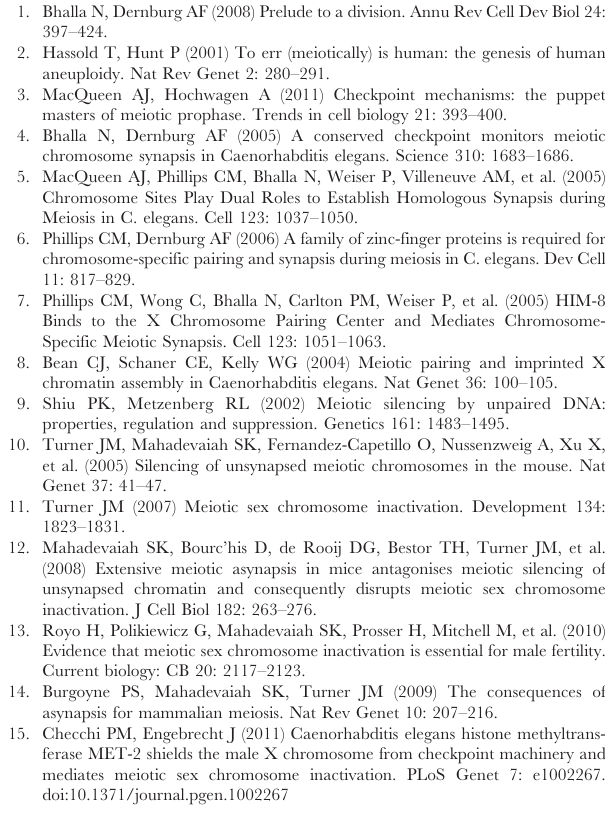
Figure S3 The delay in meiotic progression observed in meDf2 heterozygotes is not affected by mutation of mes-4 . Indirect immunofluorescence was performed against SUN-1 phosphory- lated on serine 8 in germlines from wildtype hermaphrodites, meDf2/ + mutant hermaphrodites and meDf2/ + ; mes-4 double mutants. (PDF) Figure S4 The delay in meiotic progression observed in meDf2 heterozygotes is not affected by mutation of mes-4 . Indirect immunofluorescence was performed against SUN-1 phosphory- lated on serine 12 in germlines from wildtype hermaphrodites, meDf2/ + mutant hermaphrodites and meDf2/ + ; mes-4 double mutants.